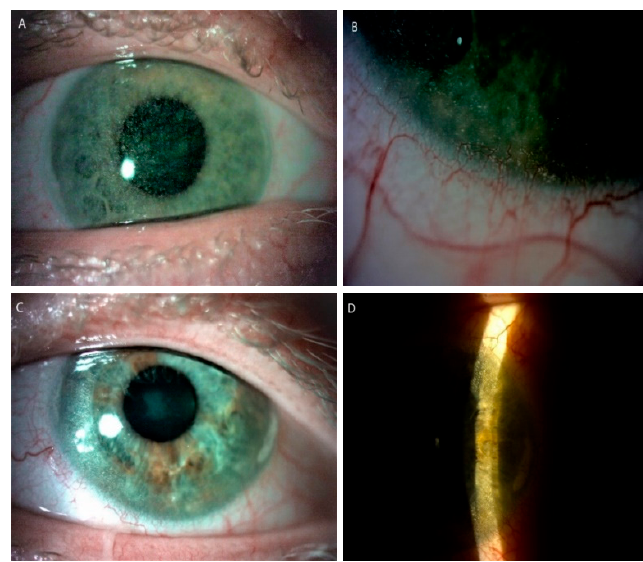
Figure 2. Slit-lamp images (10 – 25 × ) of posttransplant cornea in a patient (P7) with an infantile form of cystinosis. ( A ) Diffused cystine crystalsin right eye. ( B ) Peripheral corneal neovascularization with crystal deposits in the left eye after keratoplasty. ( C ) Cystine crystals are visible in the host cornea, in wide slit beam and ( D ) narrow slit beam in left eye.